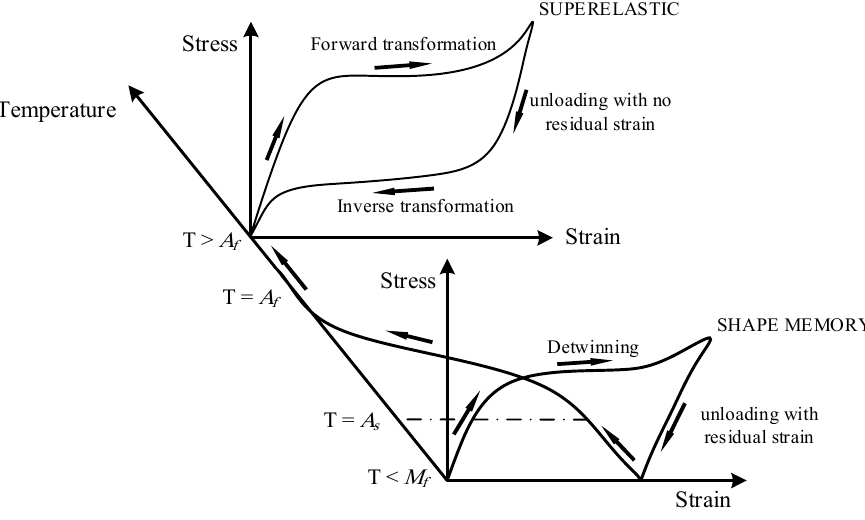
Figure 1. Shape memory and superelasticity features of SMAs [79].